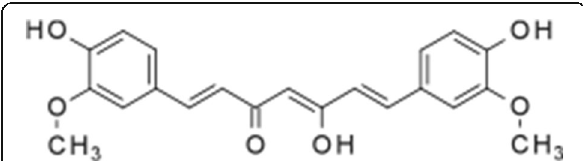
Fig. 2 Chemical structure of Curcumin enol form